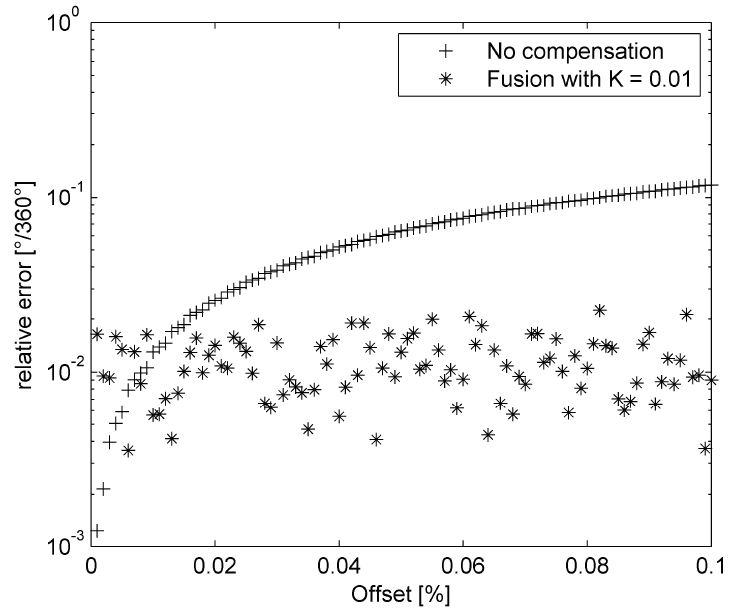
Figure 17. Relative error of roll angle estimation with respect to gyroscope